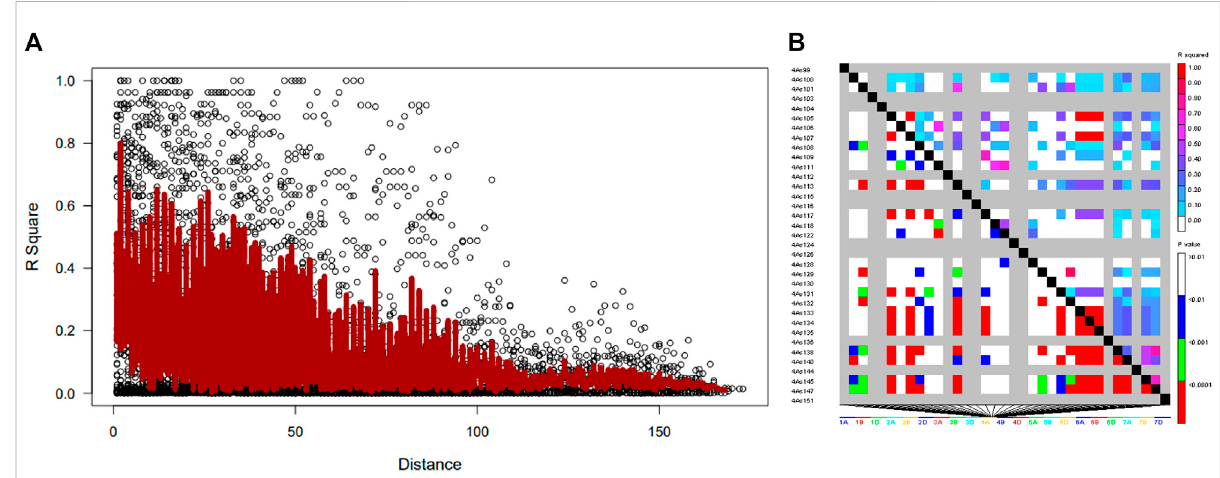
FIGURE 5 Linkage disequilibrium (LD)-measured (A) R2 plotted vs. the physical map (bp) between pairs of SNP markers in wheat genotype and (B) LD decay on chromosome